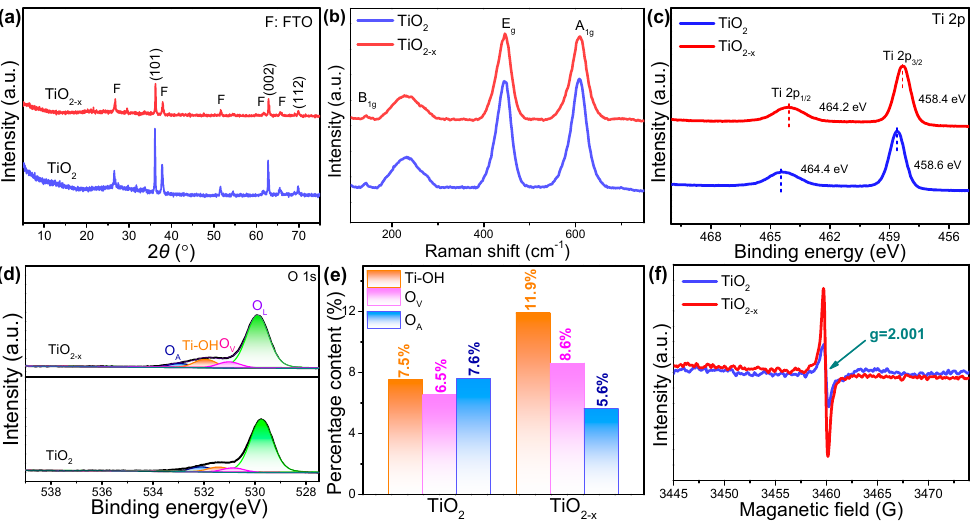
TiO 2 /NH 2 -MIL(Fe 0.25 Ni 0.75 )-88 (1.56 mA cm − 2 ) [38], Gly-TiO 2 (1.41 mA cm − 2 ) [21], Sn 3 O 4 /TiO 2 /Au (2.5 mA cm − 2 ) [39], and MnO 2 /N-TiO 2 NTs (1.95 mA cm − 2 ) [40] (Table S1).